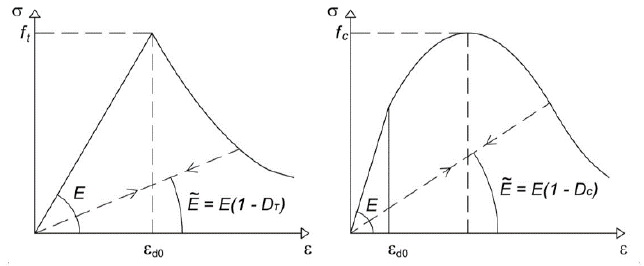
Figure 3. Concrete damage model for tension and compression stresses.